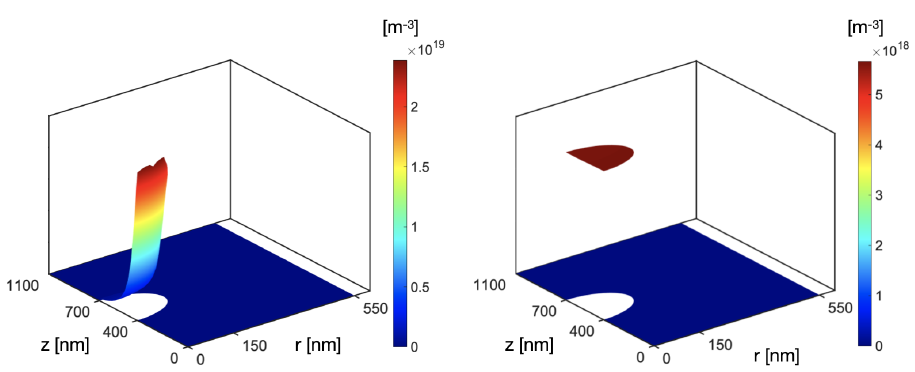
Figure 3. Electron and hole number densities in the case of R NP = 150 nm ( left ); electrons ( m − 3 ) maintain the Lambert–Beer light profile due to their limited mobility, accumulating at the illuminated interface. ( right ) Holes are ( m − 3 ) redistributed across the whole volume of the